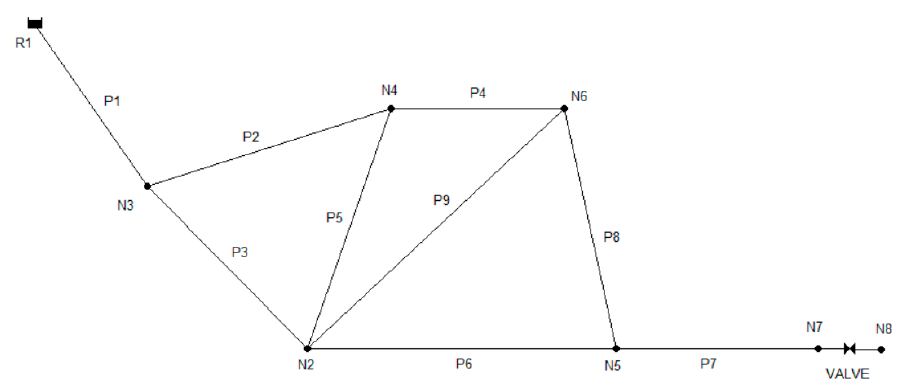
Figure 3. Tnet1 network layout.